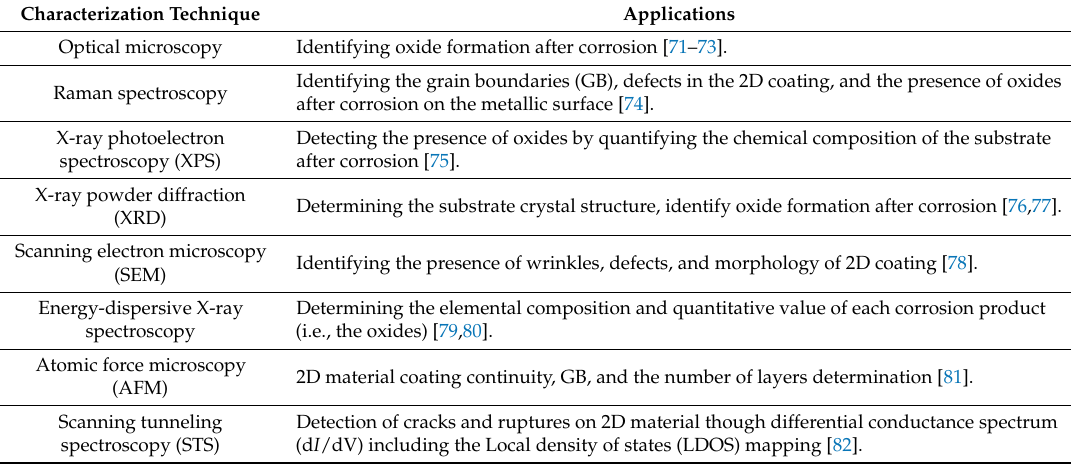
Table 1. Application of different technique in corrosion characterization of metallic